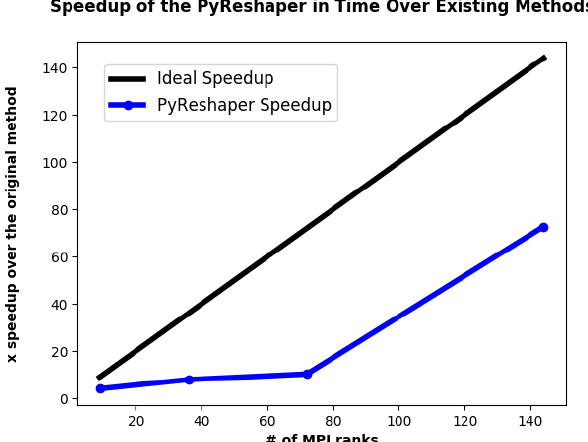
Figure 3. The comparative speedup in time of creating time-series files from 10 years of monthly atmospheric data. In all cases, 493 time-series variable files were created. For comparison, the previous CMIP5 sequential methods took approximately 5.5h to complete. With 144 MPI ranks we were able to bring the time to do this same conversion down to approximately